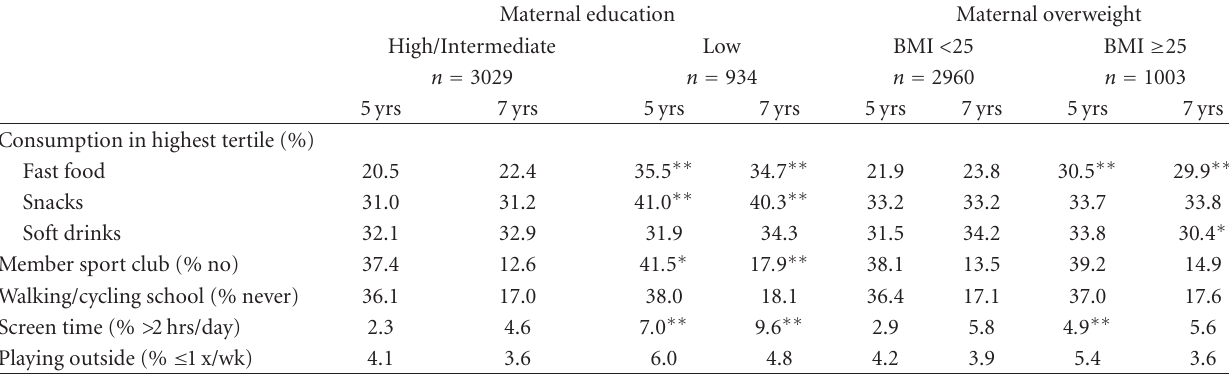
Table 3: Prevalence of dietary habits and activities at ages 5 and 7 years, stratified by maternal education and by maternal overweight.